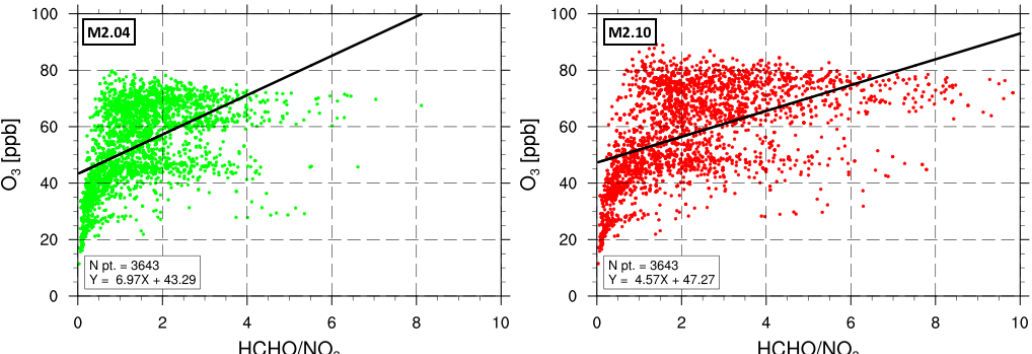
Figure 13. Scatter plot and linear regression of O 3 bias versus the ratio of HCHO / NO 2 for the simulations M2.04 (green dots) and M2.10 (red dots). Each plot shows the number of ground-based monitoring observations ( N pt.) from the AirBase database and the equation for the line of best fit ( Y